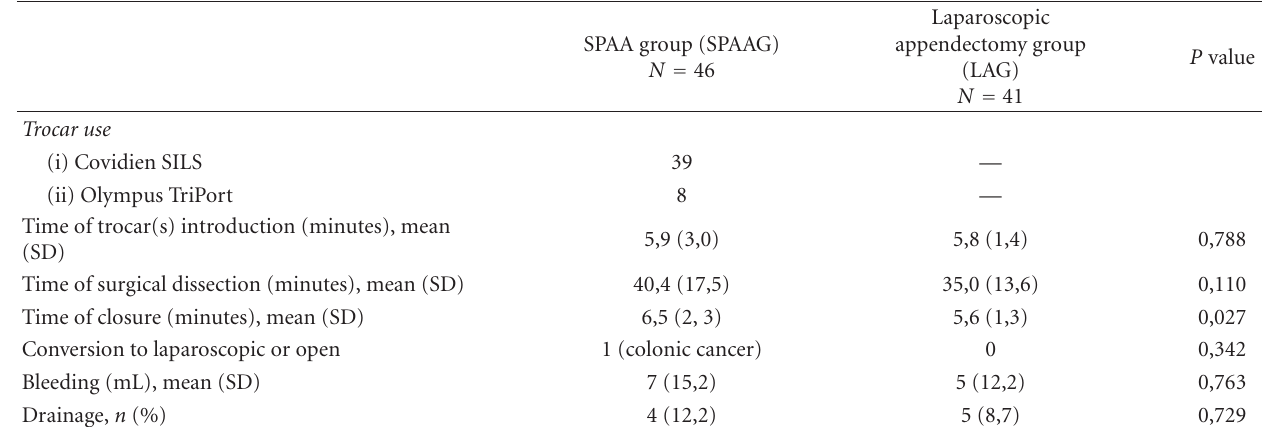
Table 2: Results concerning operative technique.